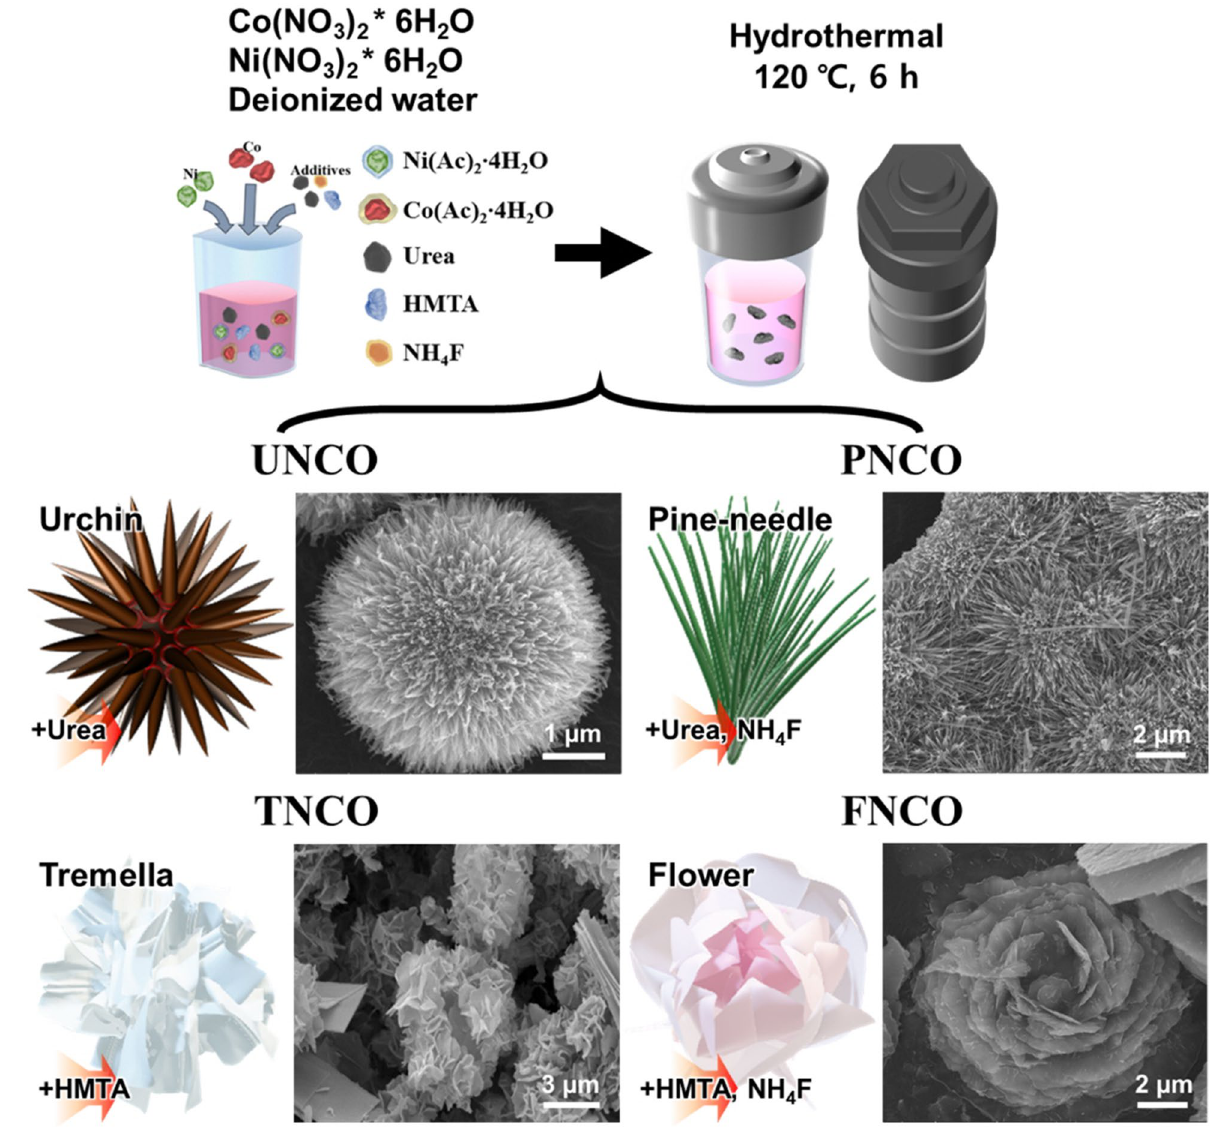
Figure 1. Schematic illustration of the formation process of morphology-controlled NiCo 2 O 4 nanostructures. The schematic and SEM images of the different nanostructures are also